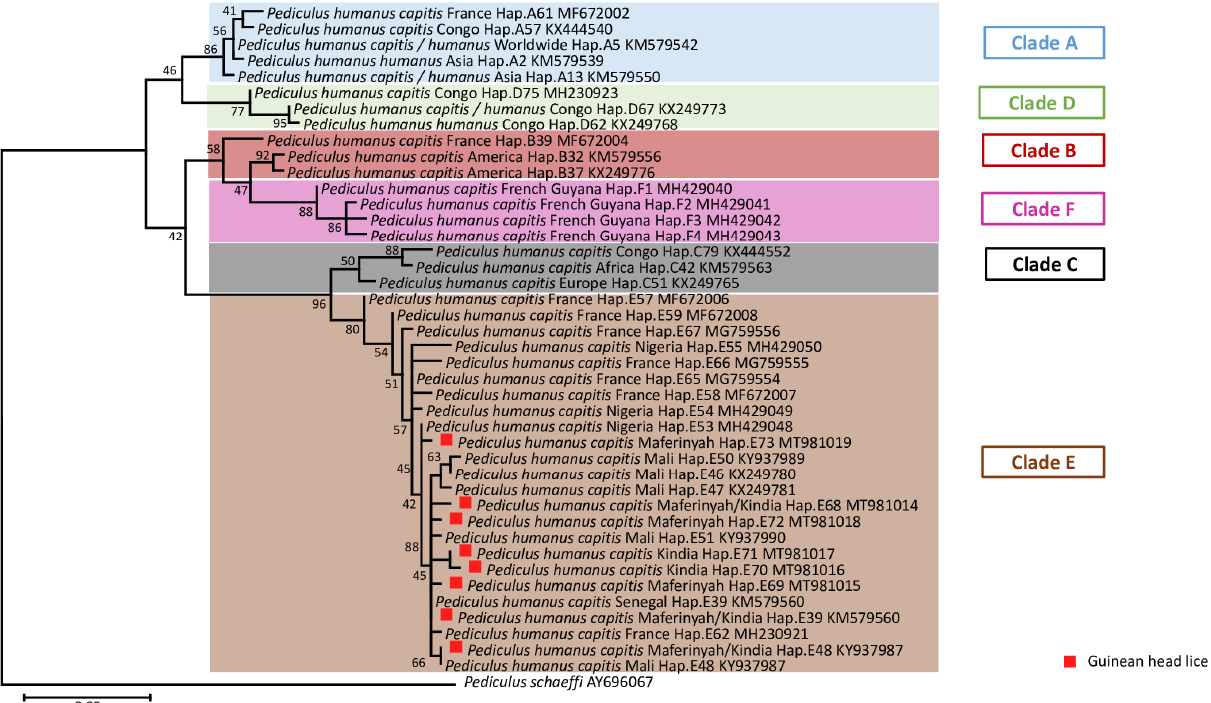
Figure 2. Maximum-likelihood (ML) phylogenetic tree of the mitochondrial cytb gene showing the relationship of haplotypes identified in this study with other P. humanus haplotypes reported in the literature. Phylogenetic inference was conducted in MEGA 7 using the maximum likelihood method under the Kimura 2-parameter with 1000 bootstrap replicates. There were a total of 141 positions in the final dataset.